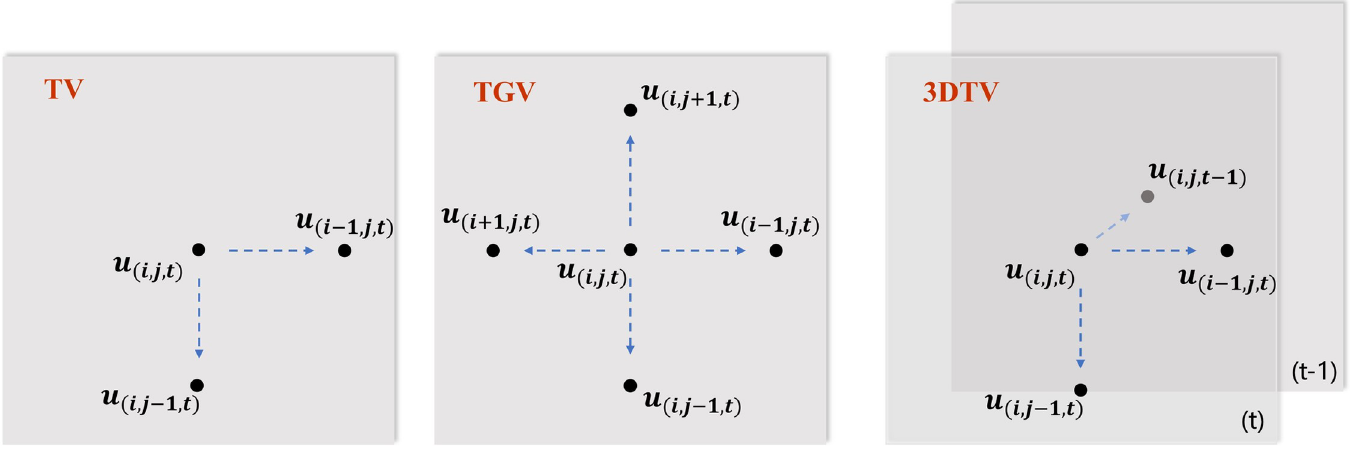
Fig 2. Associated elements among the different priors (a)TV (b) TGV (c)